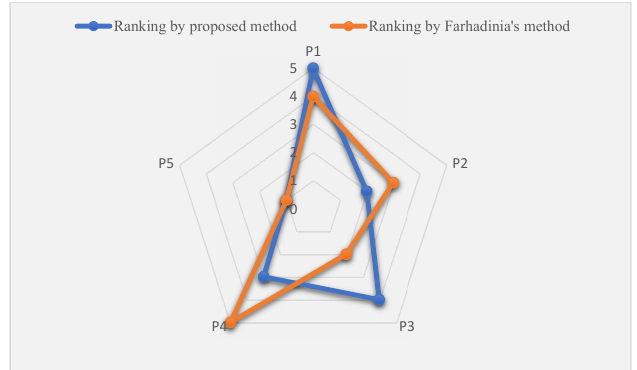
Figure 4. The ranking results of hazmats transportation alternatives with different